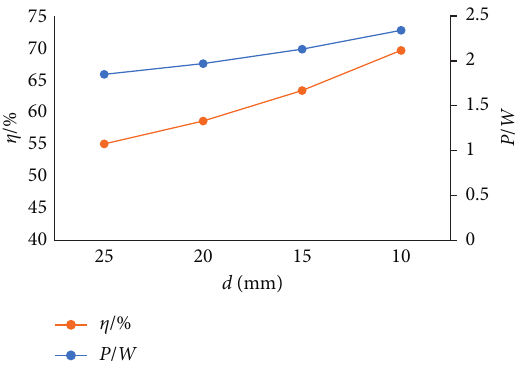
Figure 11: Comparison of experimental